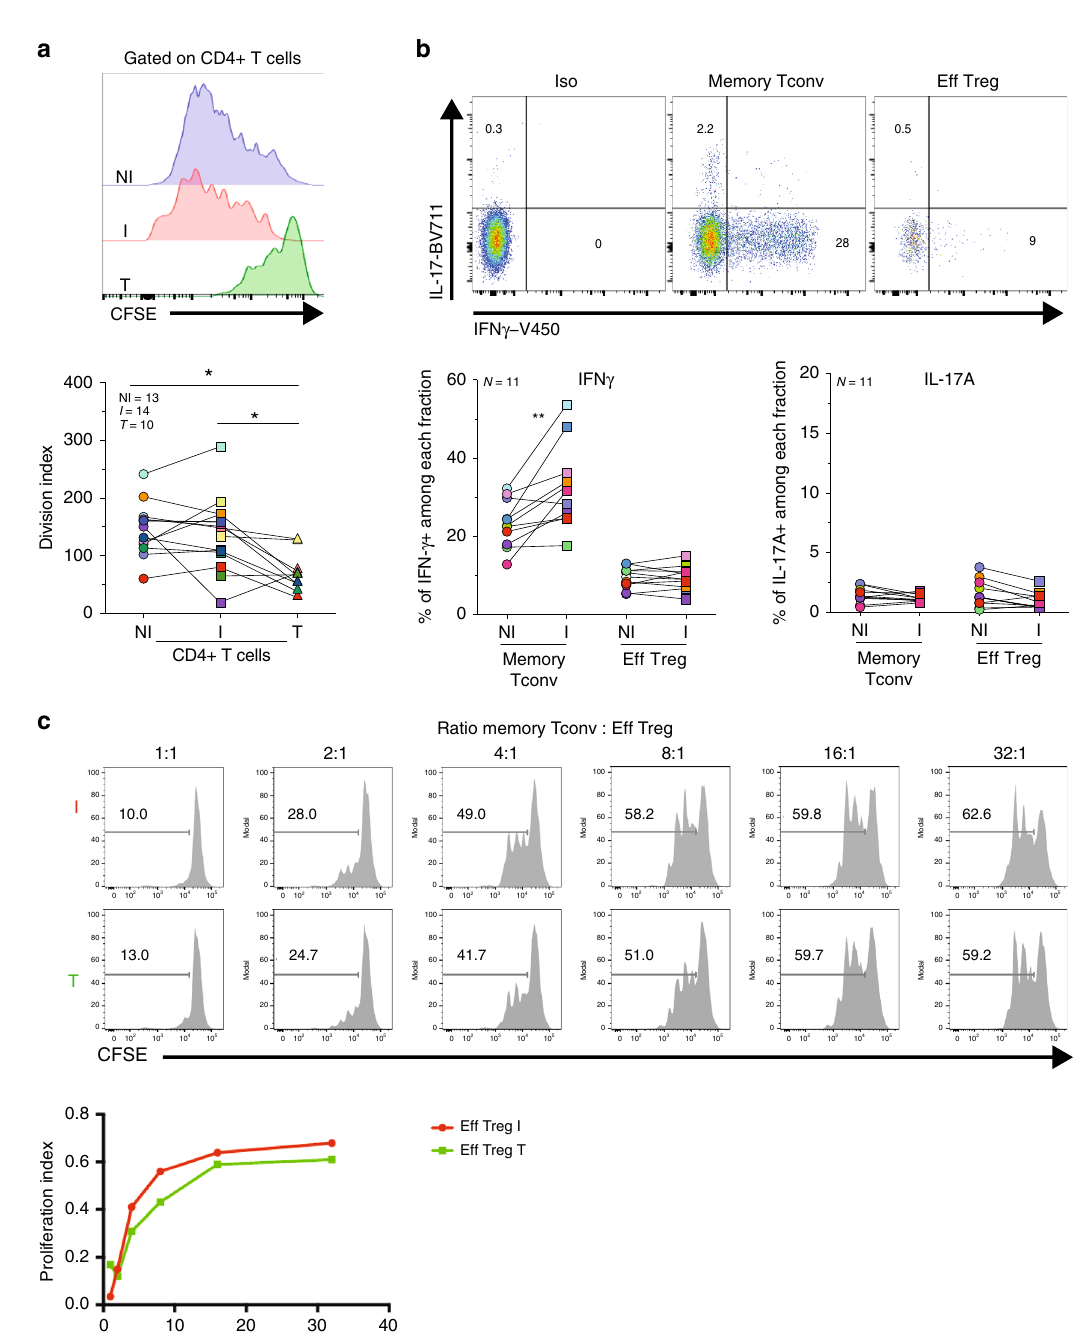
Fig. 3 Analysis of CD4 + Tconv and Treg function in TDLNs. Axillary TDLNs cells and tumors were stained with CFSE, ex vivo stimulated with anti-CD3/ CD28 beads for 96 h, and stained with CD3, CD4, CD8, and FOXP3. a Representative histograms showing CFSE dilution (left panels) and the division index (right panels) of CD4 + T cells in TDLNs and tumor ( p = 0.0156 NI TDLN vs T; p = 0.0273 I TDLN vs T). Wilcoxon matched-pairs signed rank test. b Cell suspensions of TDLNs were ex vivo stimulated with PMA/Ionomycin for 4 h and stained for CD3, CD4, IFN-g, and IL-17A. Shown is a representative fl ow cytometric analysis (upper panel) and frequency (lower panel) of IFN- γ and IL-17 among gated CD4 + T cell subpopulations from TDLN ( p = 0.0029 NI vs I TDLNs). c Evaluation of the suppression of autologous memory Tconv (CD4 + CD25 − ) proliferation by Tregs (CD4 + CD25high) sorted from fresh I TDLNs (I) and the corresponding primary tumor (T). Cells were cultured for 4 days in the presence of anti-CD3/CD28 beads. Histograms show the CFSE dilution (upper panel) and proliferation index of Tconvs in the presence or absence of Tregs at the indicated ratios (lower panel). Representative histograms ( N = 1) from one out of two independent experiments with similar results. Wilcoxon matched-pairs signed rank test, * p < 0.05, ** p <